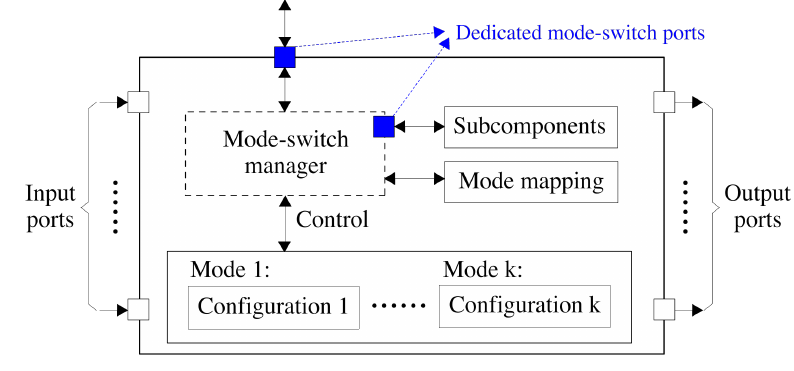
Figure 2. The illustration of a multi-mode